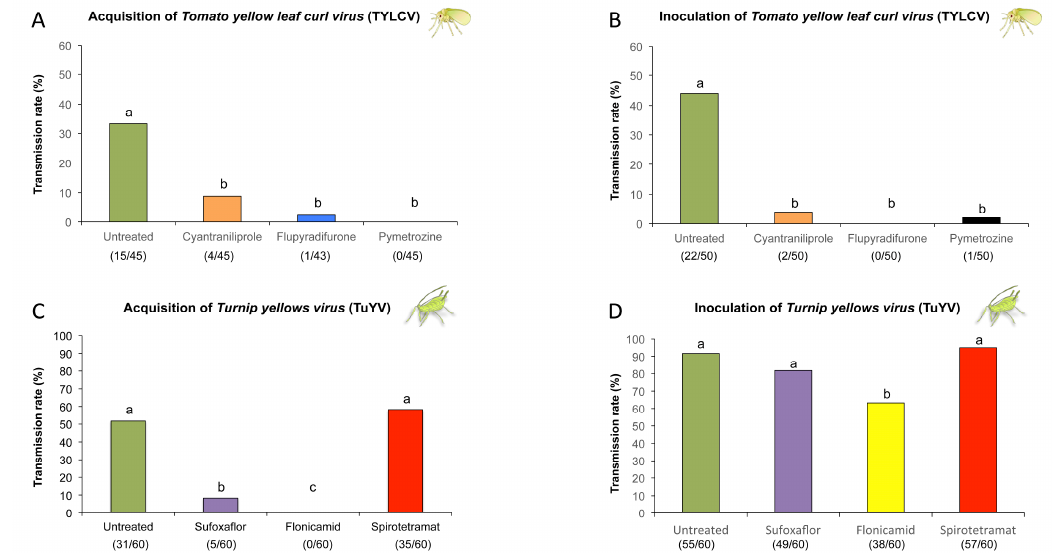
Figure 4. Transmission rate (%) of circulative viruses by insect vectors after exposure to insecticide-treated plants. ( A ) Transmission rate of tomato yellow leaf curl virus (TYLCV) by Bemisia tabaci to tomato plants after 6 h of acquisition access period (AAP) and ( B ) after 4 h of inoculation access period (IAP). ( C ) Transmission rate of turnip yellows virus (TuYV) by Myzus persicae to Physalis floridana plants after 6 h of AAP and ( D ) after 4 h of IAP. Numbers of infected plants per total number of tested plants are in